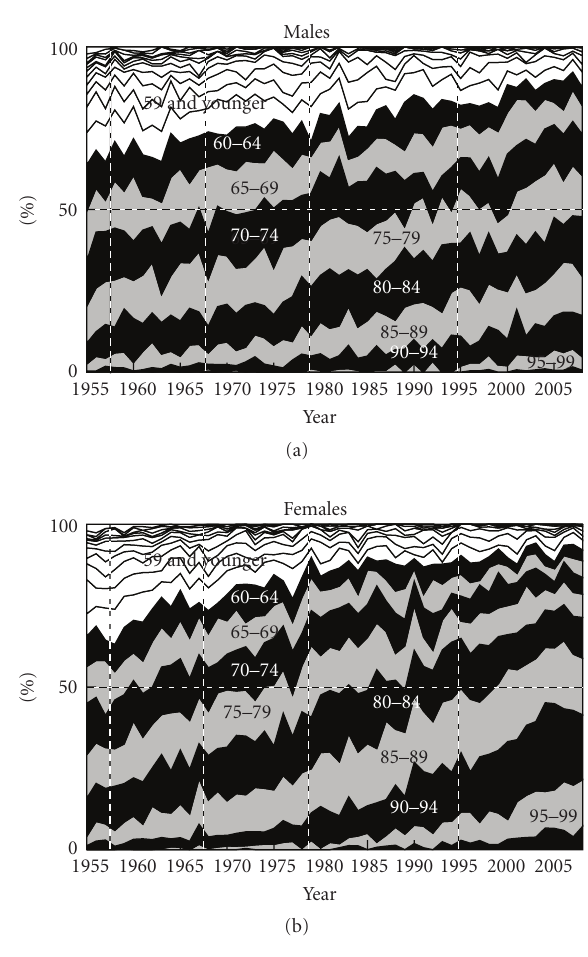
Figure 6: Annual trends in the proportion of deaths from NMSC by sex and age group in Japan (1955 ∼ 2008), modified from Ohtsuka and Nagamatsu